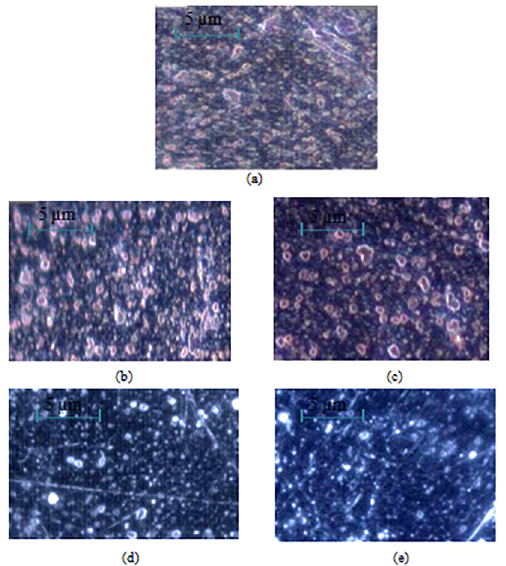
Figure 9. Al3003 without deformation; 9b-c Base side with 0.1 mm step depth and 0.7 mm step depth 9d-e: thickness side with 0.1 mm step depth and 0.7 mm step